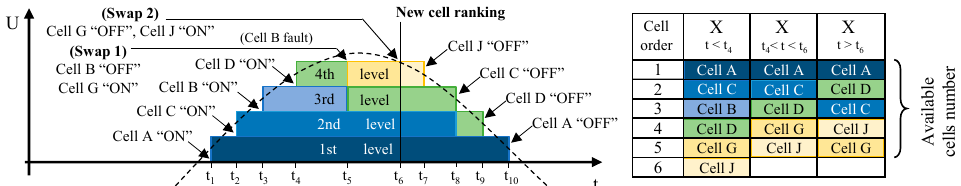
Figure 3. HF SRB cells switch control principle.